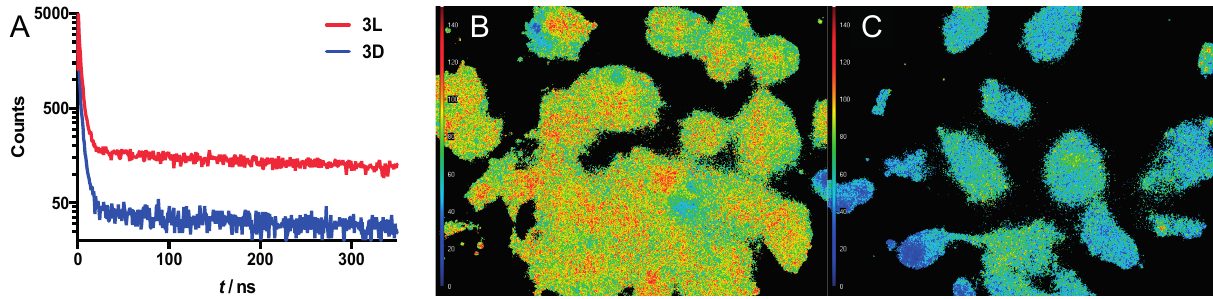
Figure 6. ( A ) Luminescence decay traces of a suspension of SKOV-3 cells after 24 h incubation with 3L (red) or 3D (blue); ( B ) FLIM image of cells incubated with 3L ; ( C ) FLIM image of cells incubated with 3D . The scalebar on the left depicts τ , going from 0 ns (blue) to 150 ns